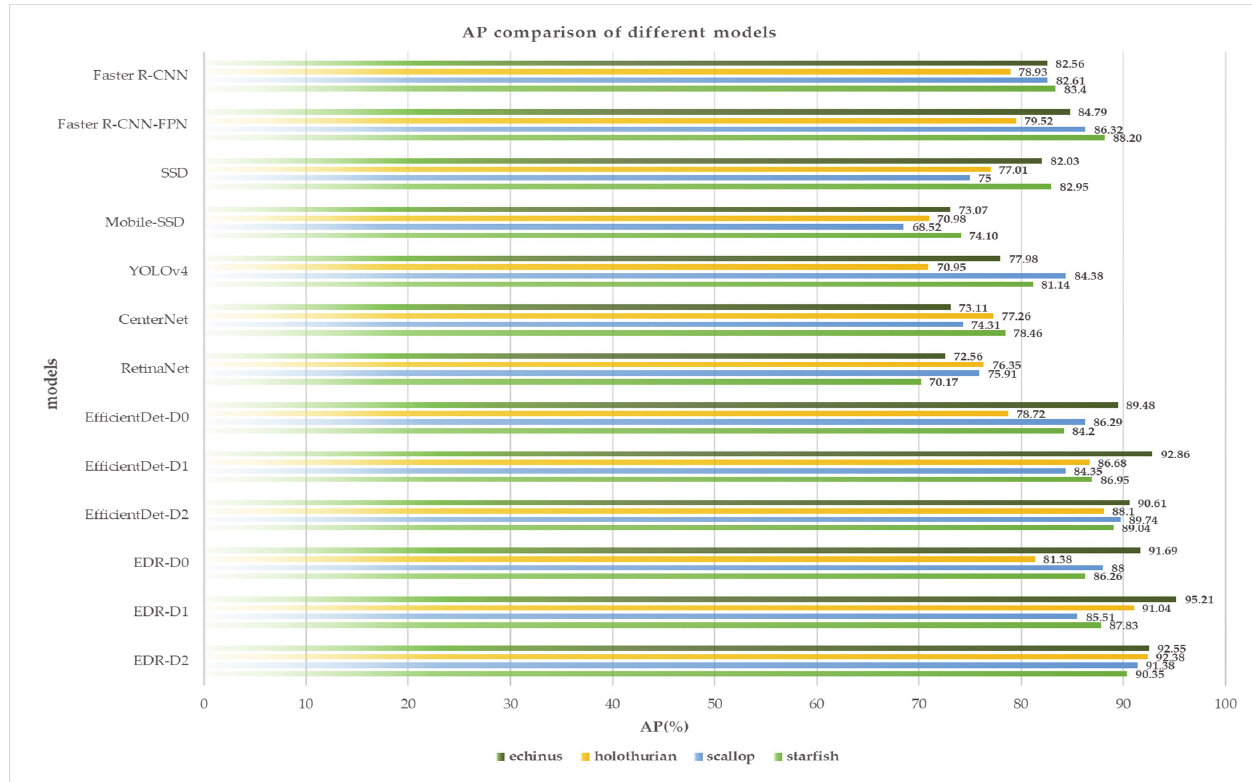
Figure 12. The AP comparison of different models in URPC dataset.